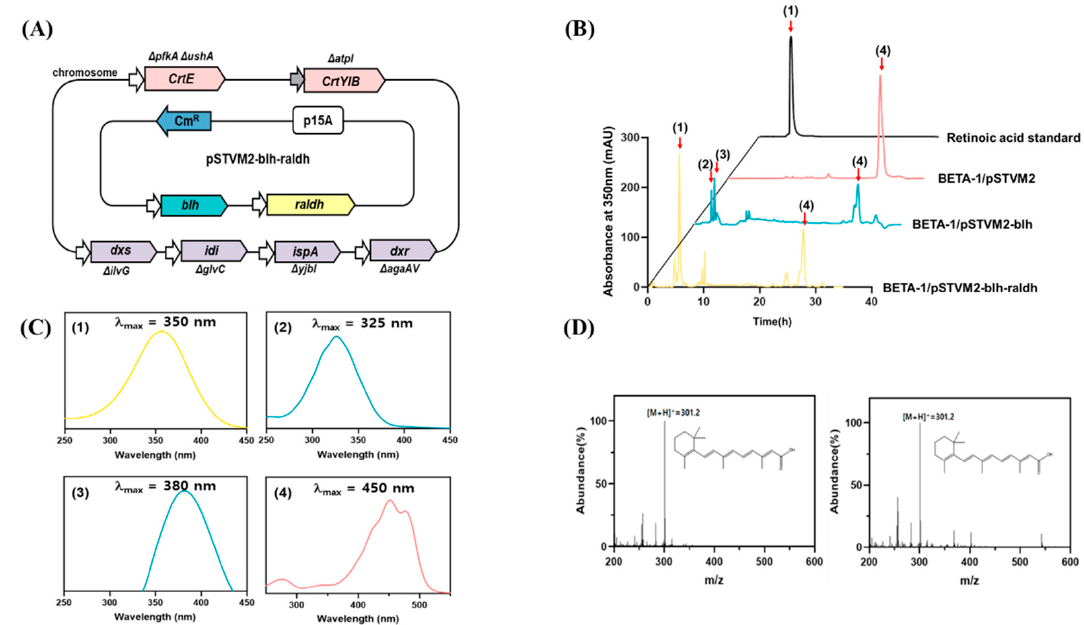
Figure 3. Reconstruction of the retinoic acid pathway and retinoid profiles in E. coli . ( A ) Schematic description of the metabolically engineered BETA-1 strain harboring the pSTVM2-blh-raldh plasmid expressing the Blh and ALDH1A2 enzymes for the biosynthesis of retinoic acid. ( B ) HPLC analysis of commercial standard retinoic acid and retinoid extracts from three recombinant E. coli strains. Peak 1 corresponds to retinoic acid; peak 2, retinol; peak 3, retinal; peak 4, β -carotene. ( C ) UV/Vis spectrum analysis of compounds corresponding to peaks 1–4 in the HPLC chromatogram. ( D ) LC–mass spectrometry analysis of a retinoic acid standard (left) and retinoic acid extracted from E. coli (right).